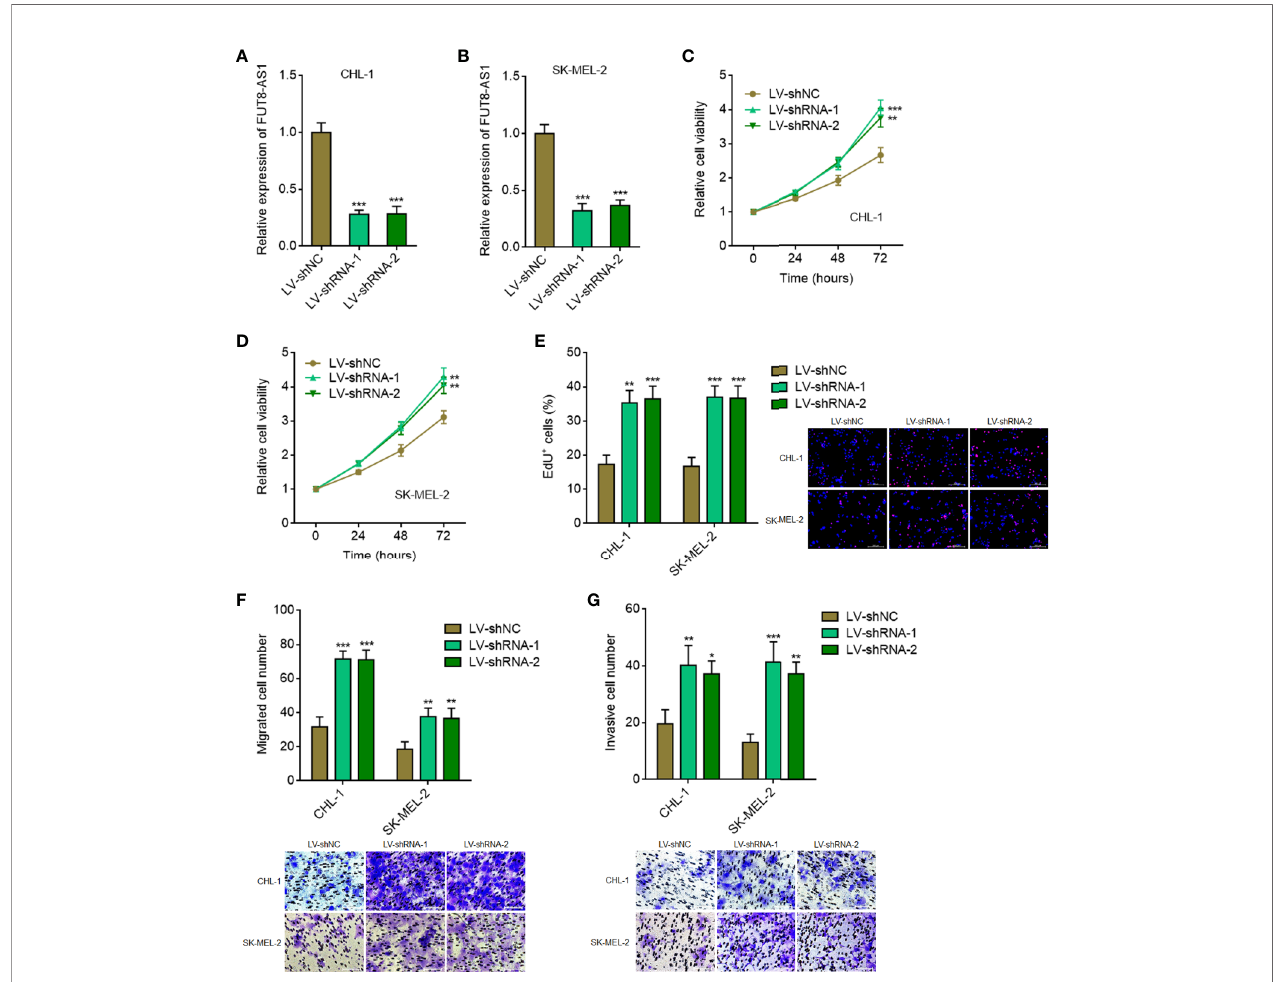
FIGURE 3 | FUT8-AS1 silencing promotes melanoma cell proliferation, migration, and invasion. (A) FUT8-AS1 expression in CHL-1 cells silencing FUT8-AS1 or control was measured by real-time PCR. (B) FUT8-AS1 expression in SK-MEL-2 cells silencing FUT8-AS1 or control was measured by real-time PCR. (C) Cell viabilities of CHL-1 cells silencing FUT8-AS1 or control were determined by the Glo cell viability assay. (D) Cell viabilities of SK-MEL-2 cells silencing FUT8-AS1 or control were determined by the Glo cell viability assay. (E) Cell proliferation of CHL-1 and SK-MEL-2 cells silencing FUT8-AS1 or control were determined by the EdU incorporation assay. The red color indicates EdU-positive nuclei. Scale bars, 200 µm. (F) Cell migration of CHL-1 and SK-MEL-2 cells silencing FUT8-AS1 or control were determined by the transwell migration assay. Scale bars, 100 µm. (G) Cell invasion of CHL-1 and SK-MEL-2 cells silencing FUT8-AS1 or control were determined by the transwell invasion assay. Scale bars, 100 µm. Data are presented as mean ± SD. * P < 0.05, ** P < 0.01, *** P < 0.001 by one-way ANOVA followed by Dunnett ’ s multiple comparisons